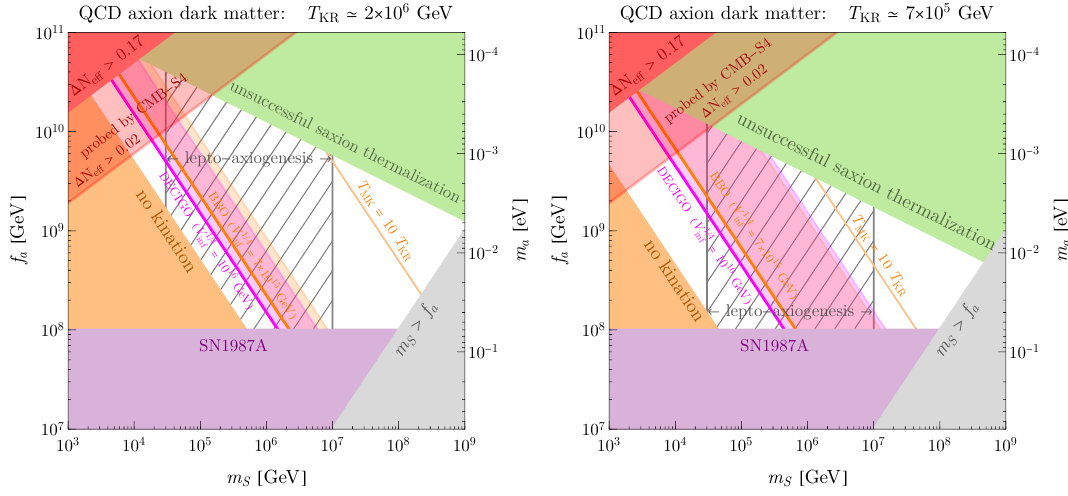
Figure 9 . Parameter space for the QCD axion dark matter produced by kinetic misalignment, which predicts T KR ’ C × 2 × 10 6 GeV as can be seen in figure 5. The left (right) panel assumes C = 1 (0 . 3) . The regions above the thick magenta and orange lines lead to a primordial gravitation wave signal that can be probed by DECIGO and BBO for the labeled choices of V 1 / 4 the adjacent transparent shadings, the peak of the spectrum can be detected by each observatory. The signal is made possible by the kination era; otherwise, V 1 / 4 for